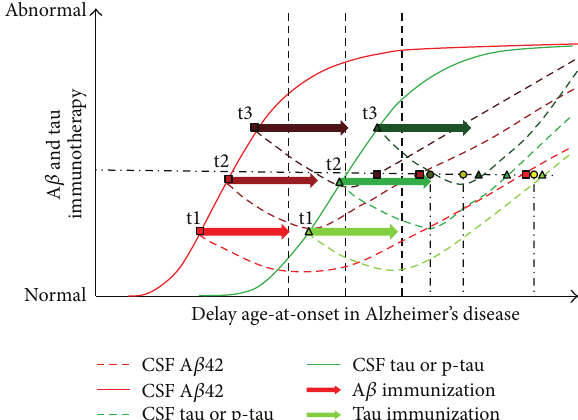
Figure4:HypotheticalmodelillustratingthesynergiceffectA 𝛽 and Tau immunotherapies combined together could have on the delay predilection of age-at-onset in progressing throughout Alzheimer’s disease stages. The literature supports the notion that A 𝛽 is not enough to treat AD symptoms, and recently tau immunotherapy may help in preventing cognitive decline in mouse AD model. This graph shows the effect each immunotherapy could have over time when giving at different pathological timelines (t1, t2, and t3). Excluding time-course, time-interval, and efficacy of A 𝛽 and tau immunization might influence the outcome of neuropathological changes; both immunotherapies may show promise in delaying neurofibrillary tangles burden clearance into the brain, cognition decline, and clinical stages. Resulting code color glow circles are from t1 A 𝛽 + t1 tau, t2 A 𝛽 + t2 tau, and t3 A 𝛽 + t3 tau,